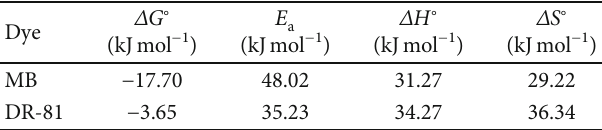
Table 1: Thermodynamic parameters for the decolorization of MB and DR-81 by the synthesized Zn-adeninate